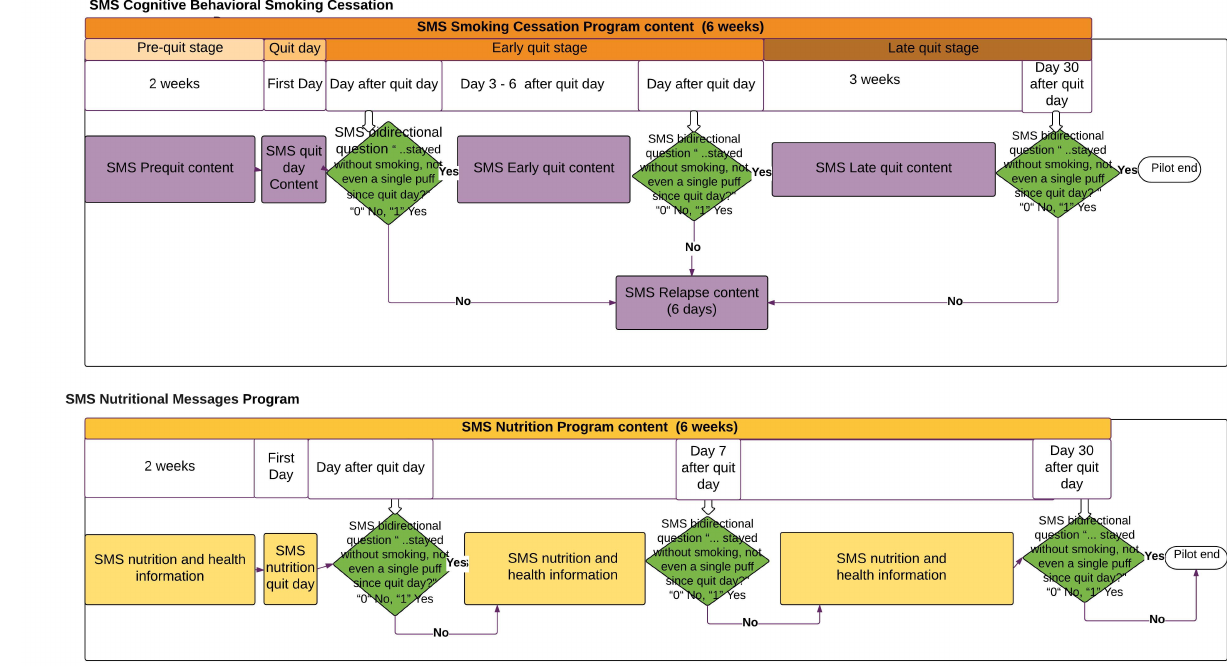
Figure 4. Flowchart of the SMS text message smoking cessation program and the SMS text message nutrition program